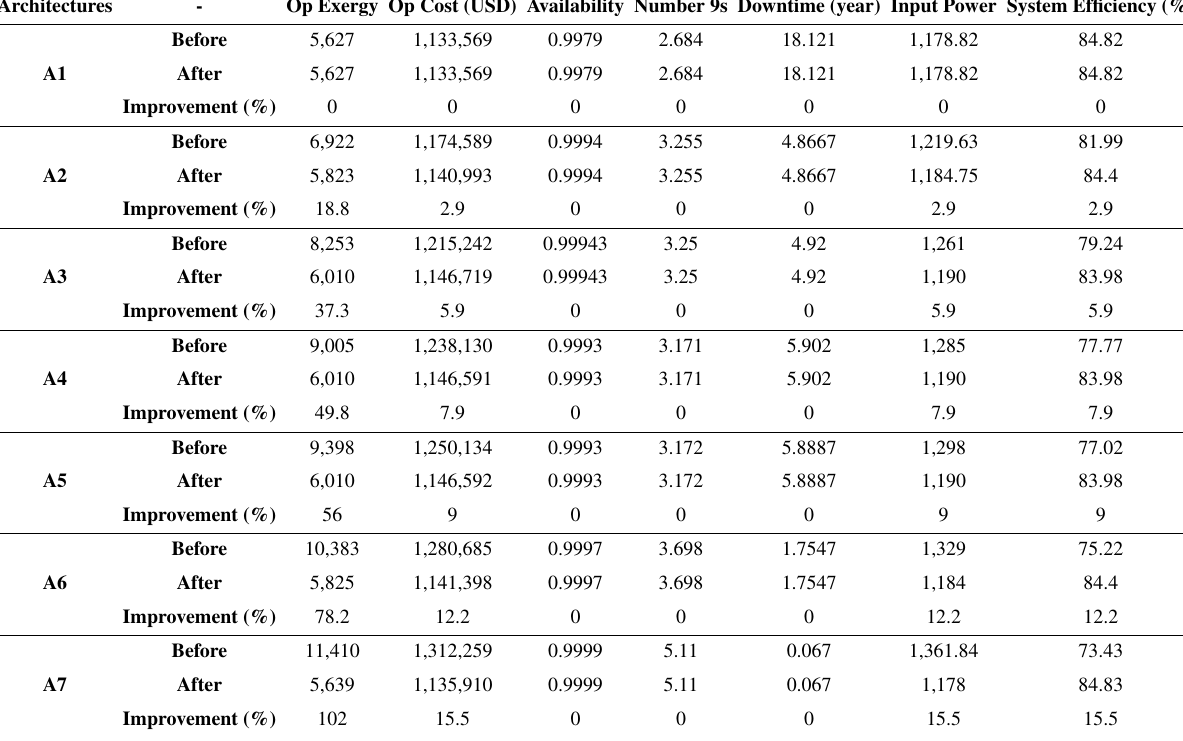
Table 4. Results of PLDA execution with improvement in %.